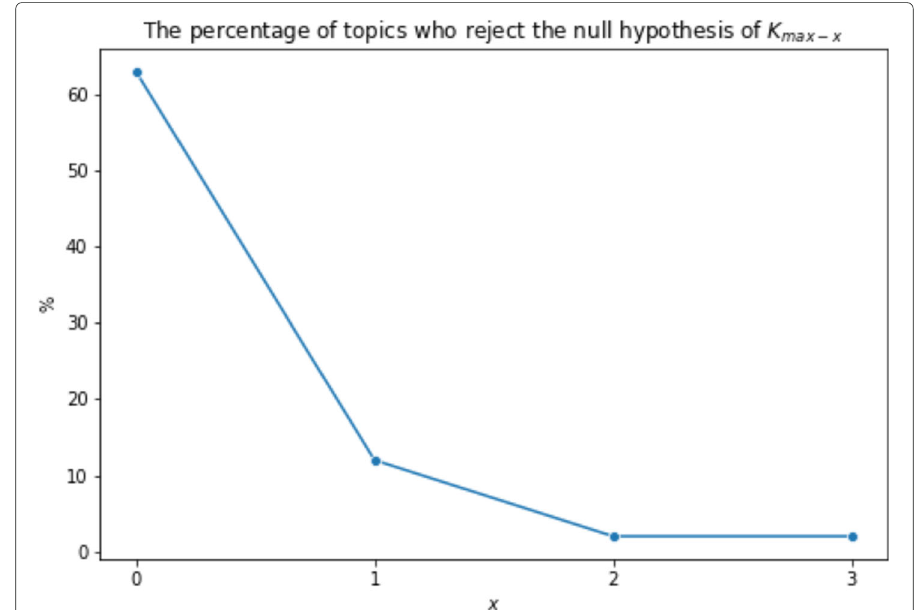
Fig. 7 The percentage of topics who reject the null hypothesis of P ( k ≥ k max − x ) for varying